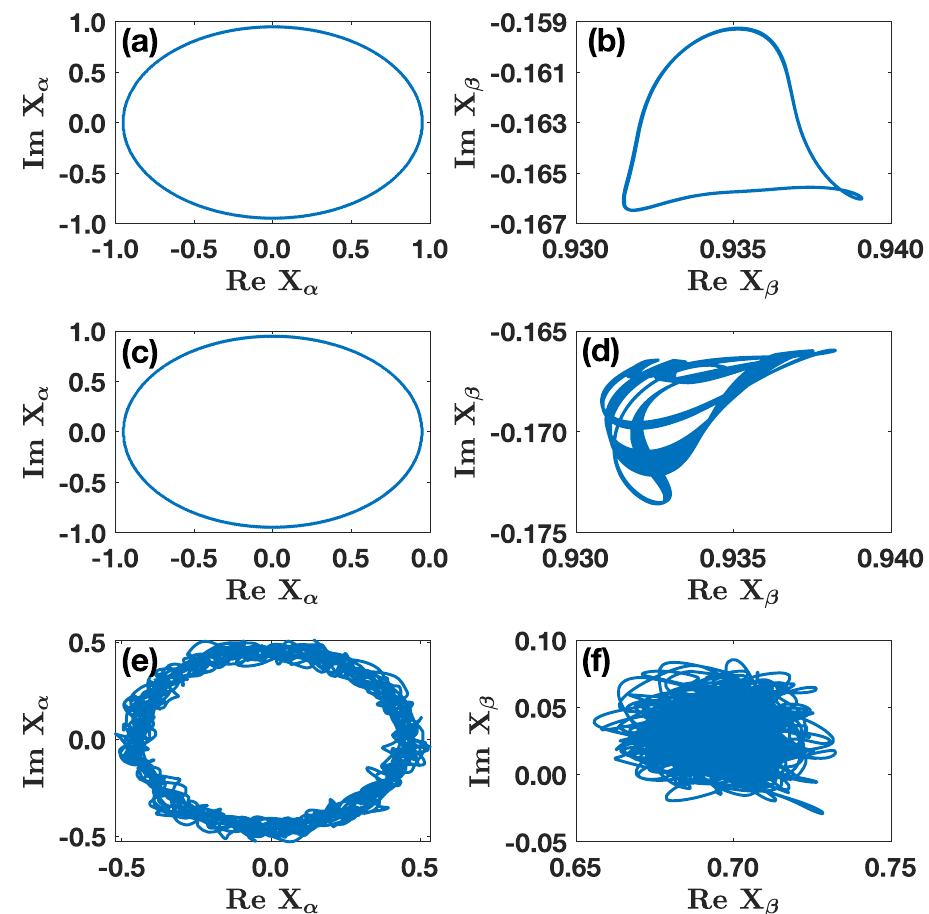
Fig. 6 Phase portraits of the order parameters. The trajectories of the real and imaginary parts of the complex order parameters X α and X β are displayed for different values of the coupling constant σ in the backward transition. These results are obtained by neglecting the transient, in a network of N = 500 nodes with σ = 3.4 ( a , b ), with σ = 3.37 ( c , d ) and with σ = 1.69 ( e , f